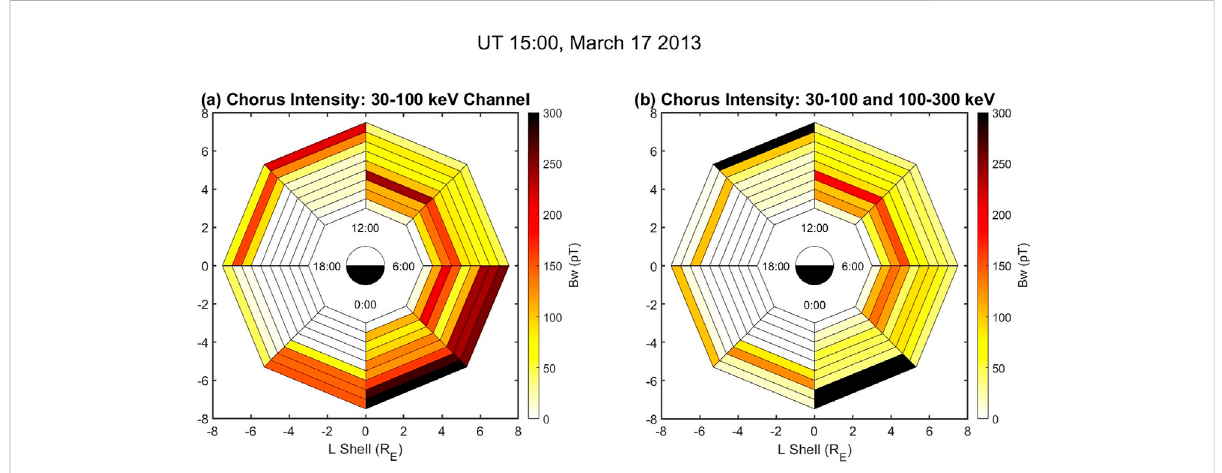
FIGURE 6 Inferred values of chorus wave intensity, Bw. In plot (A) the diffusion coef fi cients are scaled using only the 30 – 100 keV range from MEPED. In plot (B) the diffusion coef fi cients are scaled using the new method that accounts for changes in plasma density by matching the 30 – 100 keV and 100 – 300 keV results. The inferred chorus intensity using only the 30 – 100 keV range (plot a) is consistently larger than the inferred chorus intensity using both energy ranges to account for changes in f pe / f ce (plot b). A movie showing the chorus intensity at every time step is included in the